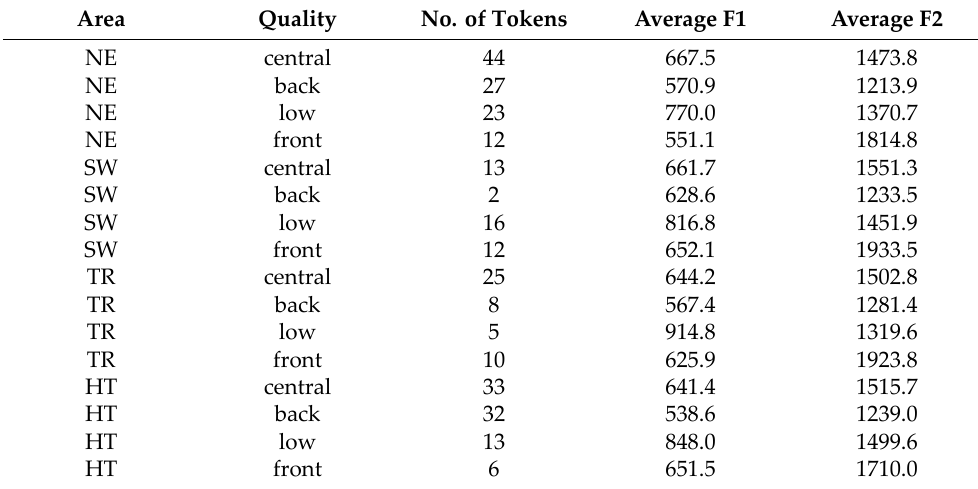
Table 3. Summary of results by alternative grouping.